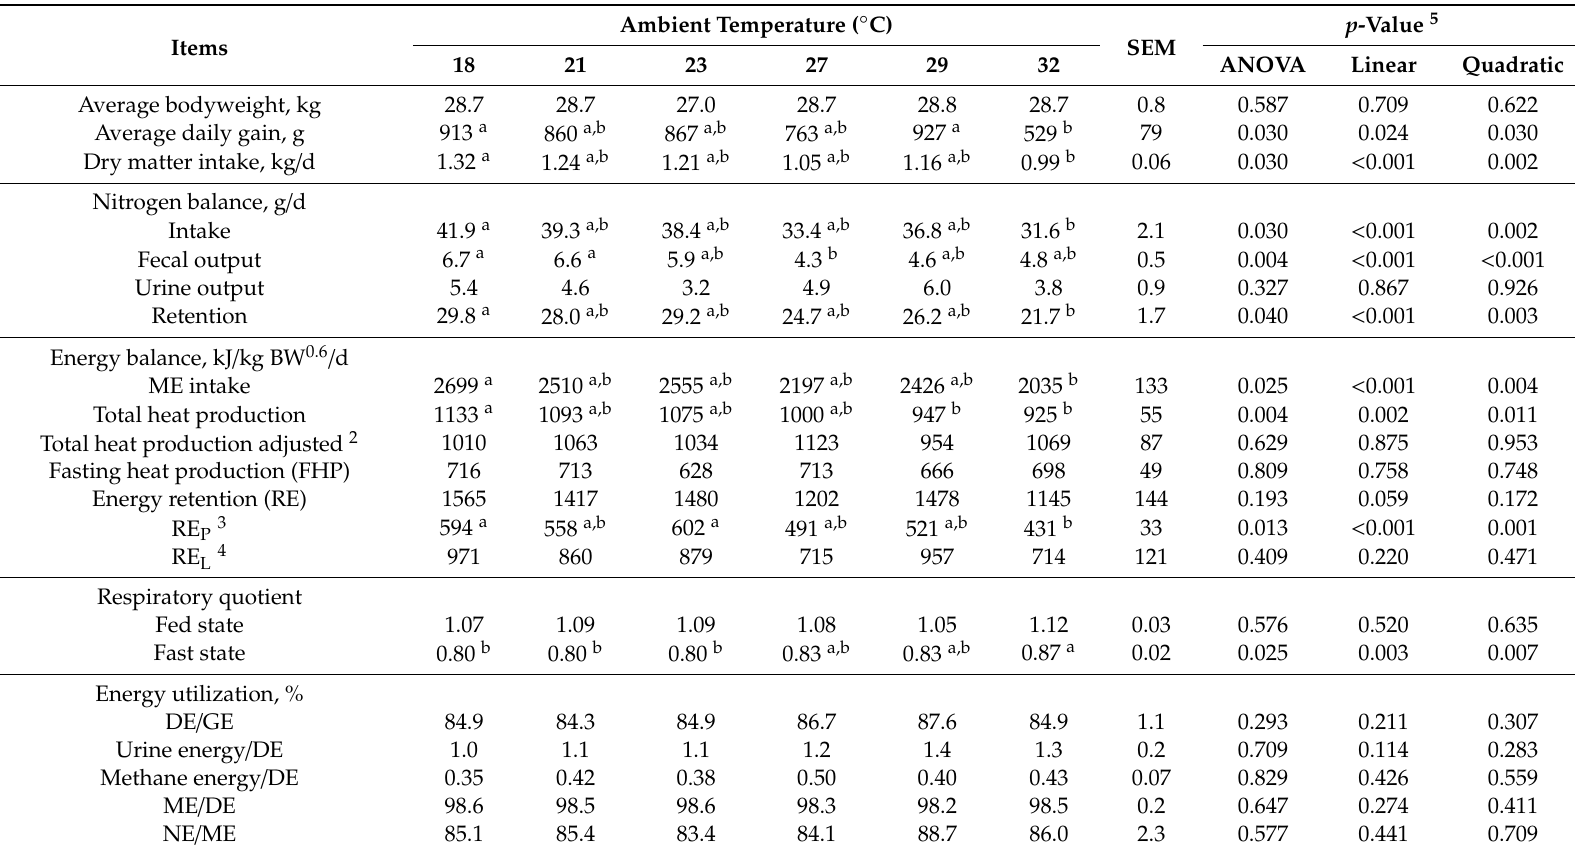
Table 2. Nitrogen and energy balance of barrows at 25 kg kept at di ff erent ambient temperatures 1